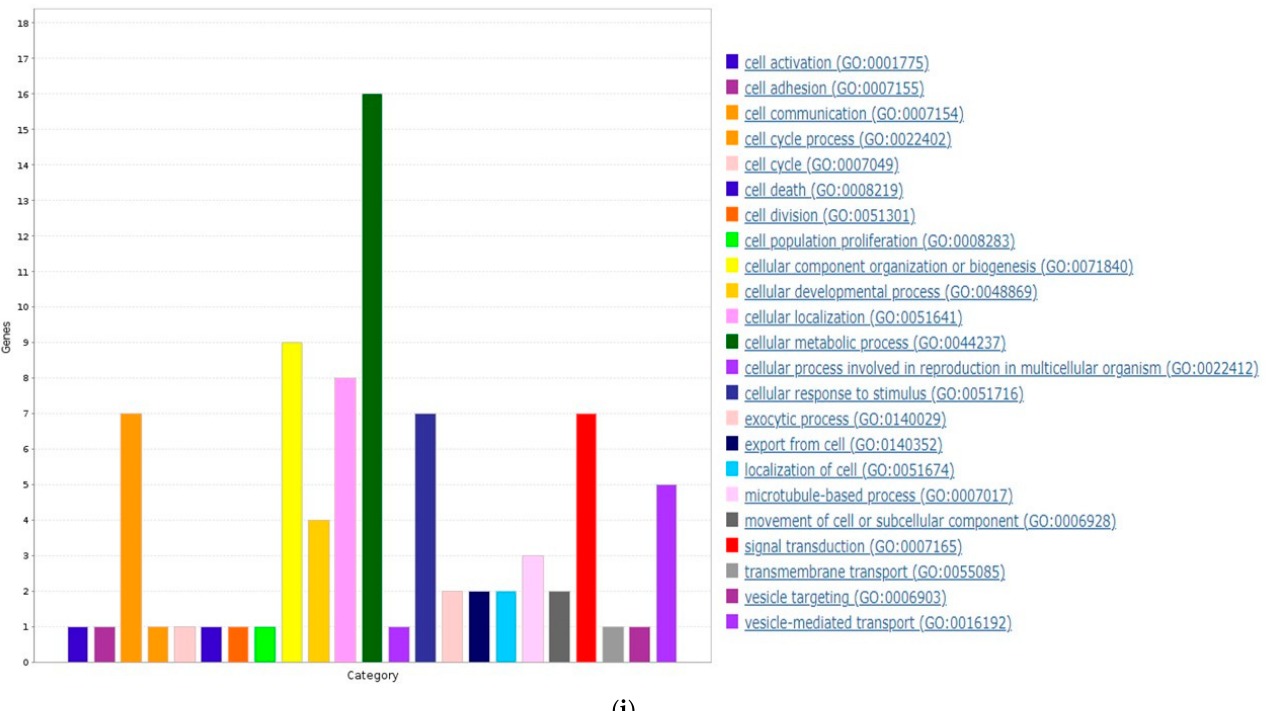
Figure 7. Expression of potential ZNF433 target genes in clear-cell renal carcinoma. ( a ) A heatmap generated using UALCAN analysis to determine the expression of predicted ZNF433 target genes in clear-cell renal cell carcinoma. ( b – h ) Most notable targets implicated in cancer suppression, progression, or tumorigenesis that had significant changes in ccRCC relative to normal, as well as those previously identified ( n = 535). ( i ) A pie chart featuring biological processes in which target genes are components, generated using PANTHER (http:// pantherdb.org, accessed on 9 May 2021). ( j ) The largest category of the biological processes was a cellular process (GO: 0009987). The bar graph shows the number of ZNF433 target genes associated with the GO subcategories under the cellular process.